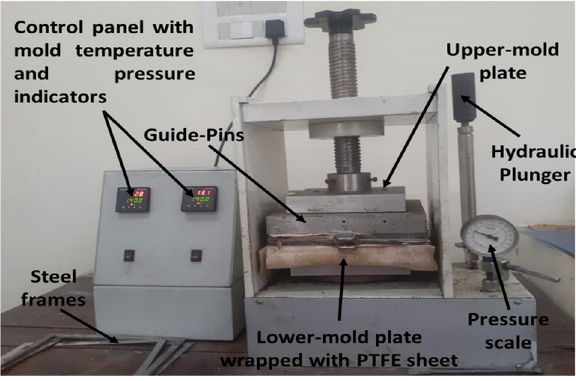
Figure 5: Hot - press compression molding.